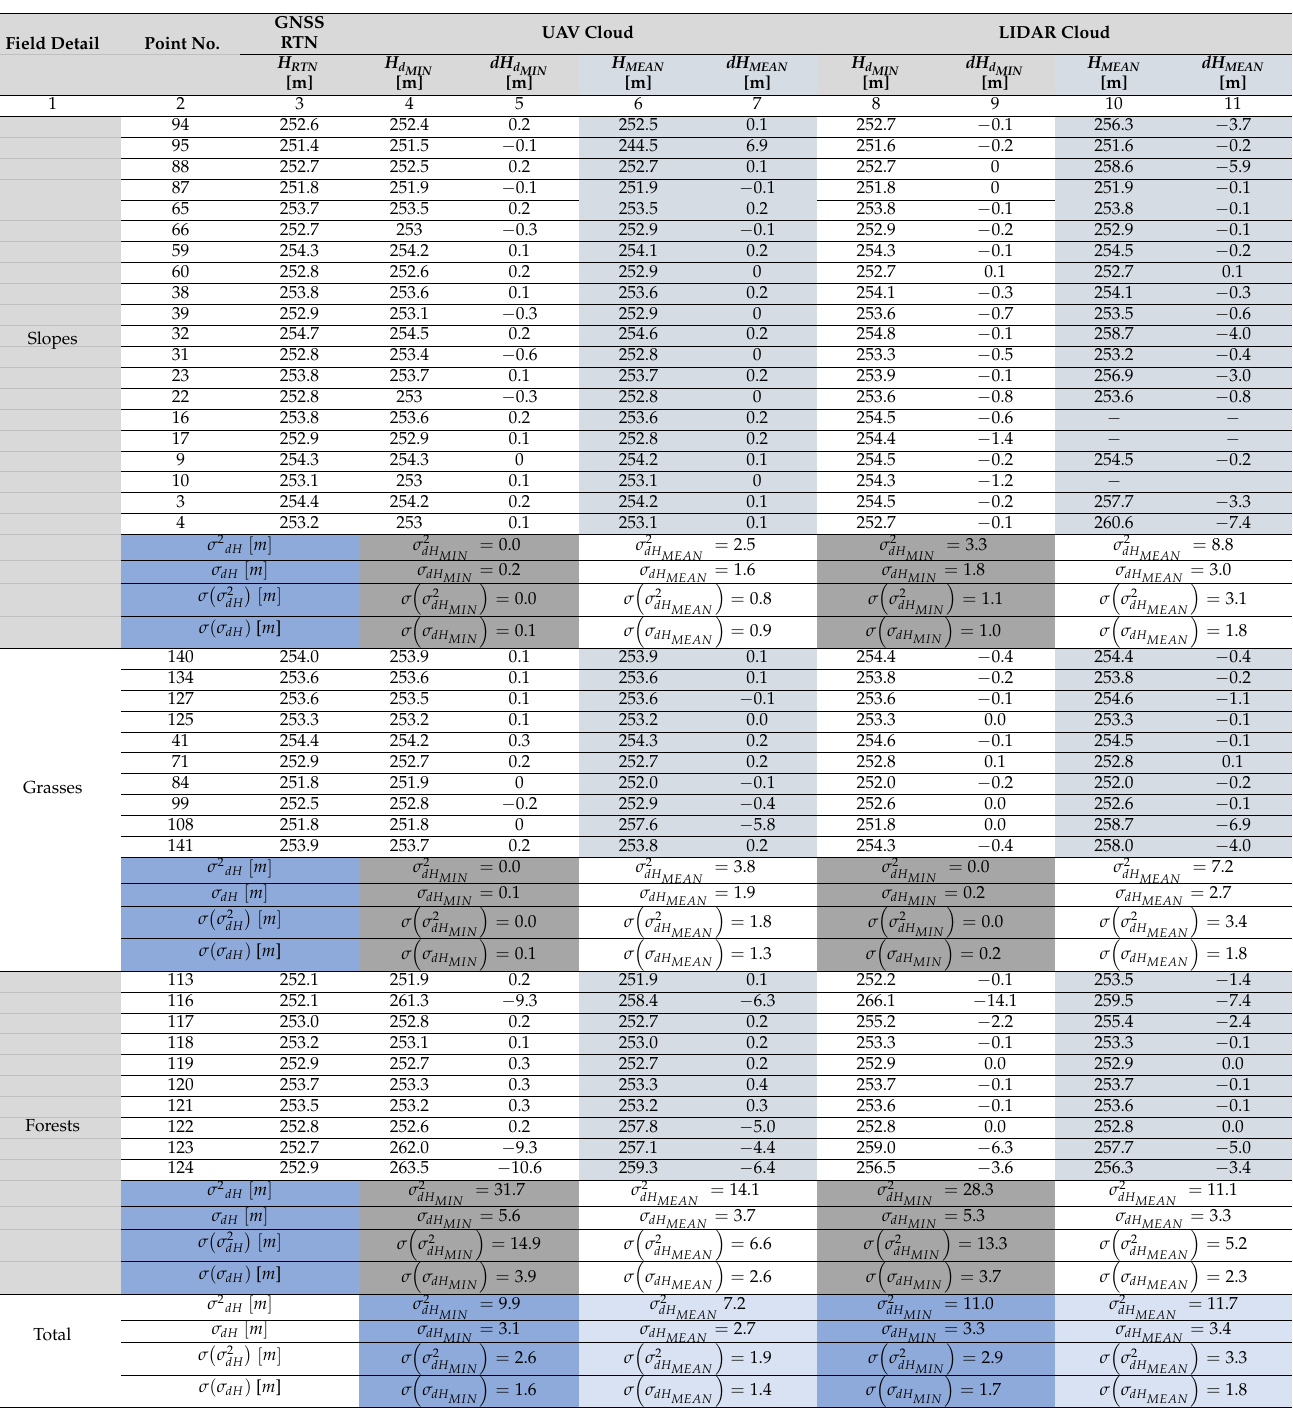
Table 2. Comparison of point heights measured in the field using the GNSS RTN technique with point heights read from LIDAR and UAV point clouds; source: own